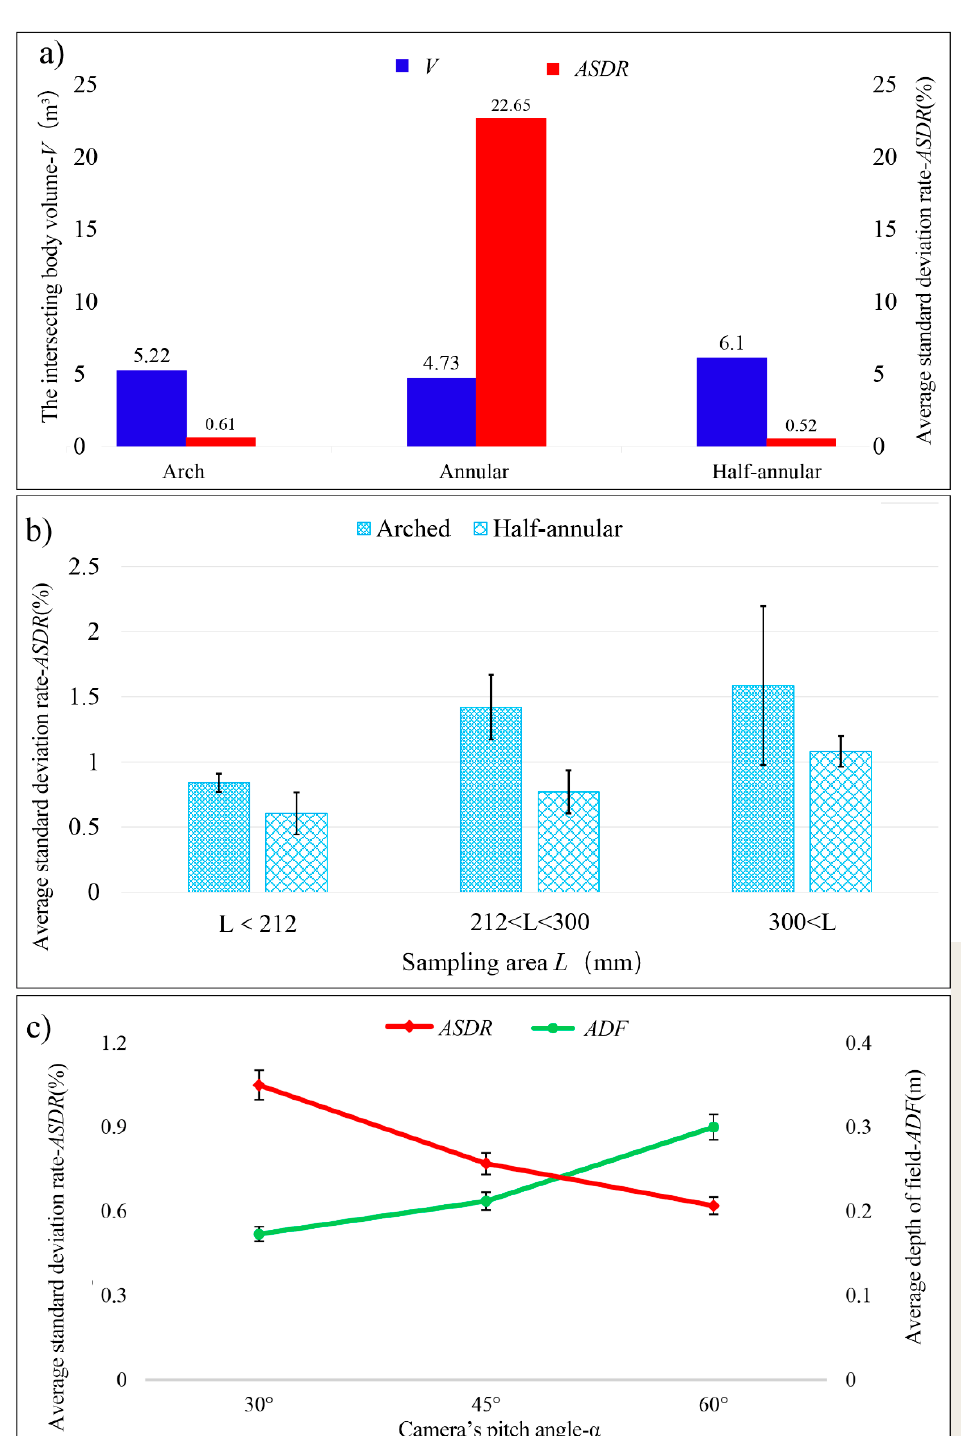
Figure 7. ( a ) Contrast between the viewing volume of the three types of camera layouts and the average deviation ratio (in order to compare the viewing volume and the capture deviation ratio together and increase the volume value to 100 times); ( b ) The ASDR of three lengths of sampling area ( L ) in the arched and half-annular layout patterns; ( c ) Three pitches in a half-annular layout Comparison of Actual Depth of Field and Standard Deviation Rate at Angles (30°, 45°, 60°).